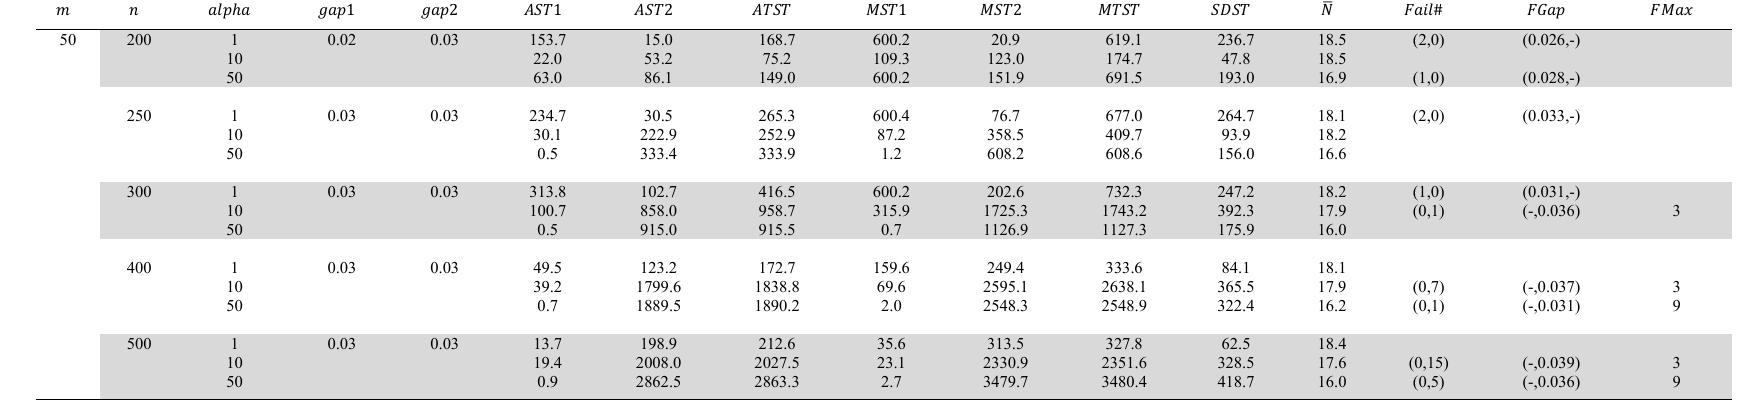
Experimental results of applying the MILP solution procedure for the problem instances with 50 machines